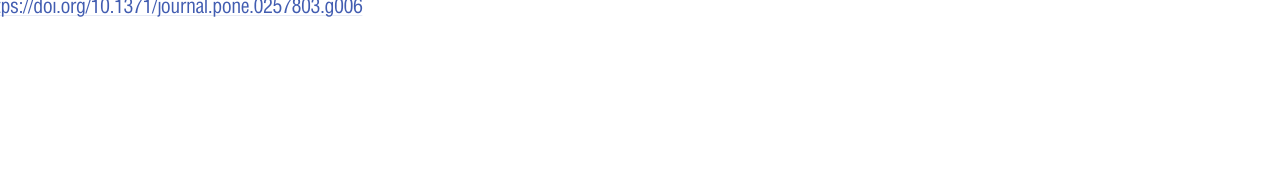
PLOS ONE | https://doi.org/10.1371/journal.pone.0257803 September 28,